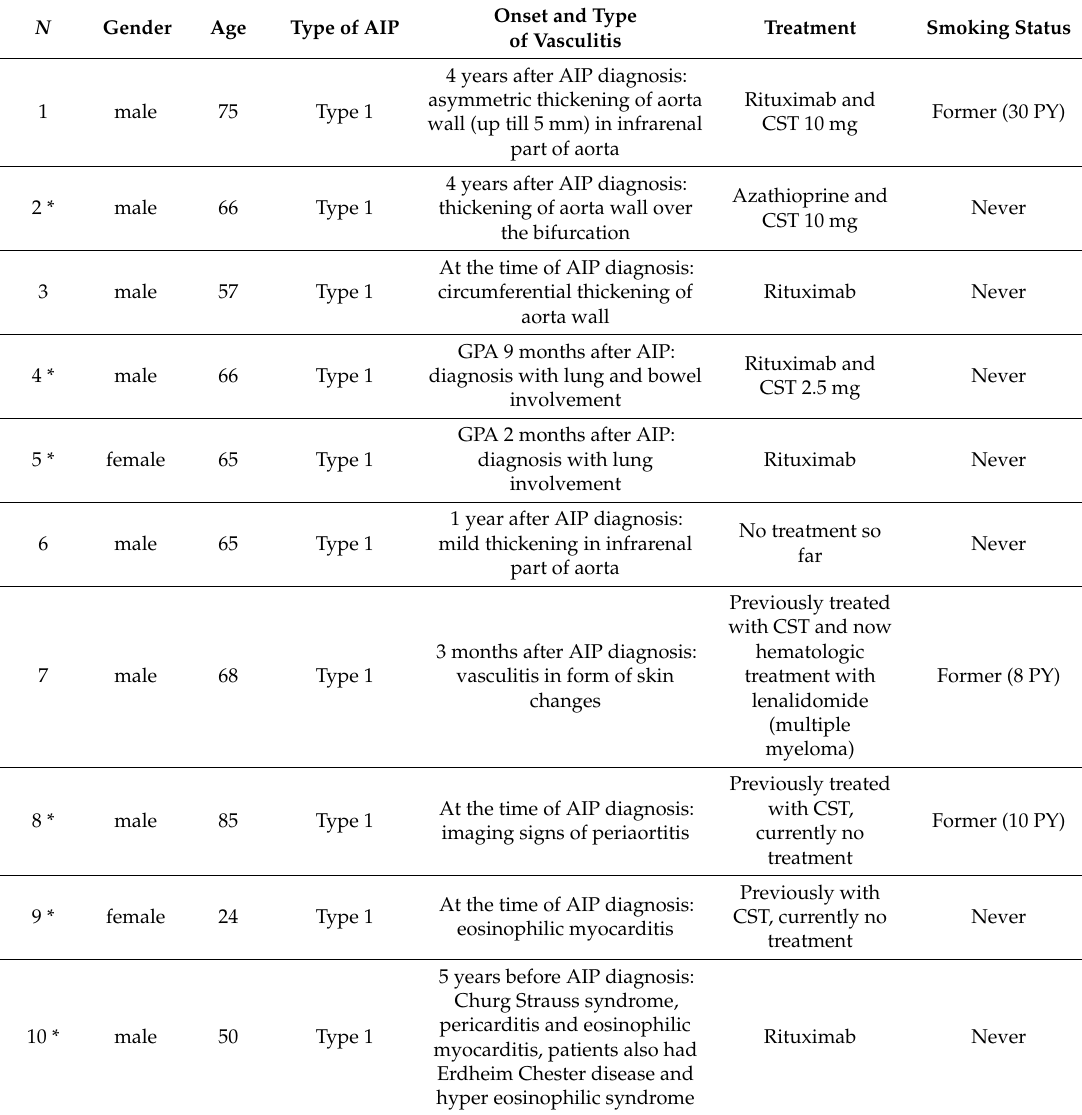
Table 3. Demographic and clinical features of patients with AIP type 1 and cardiovascular